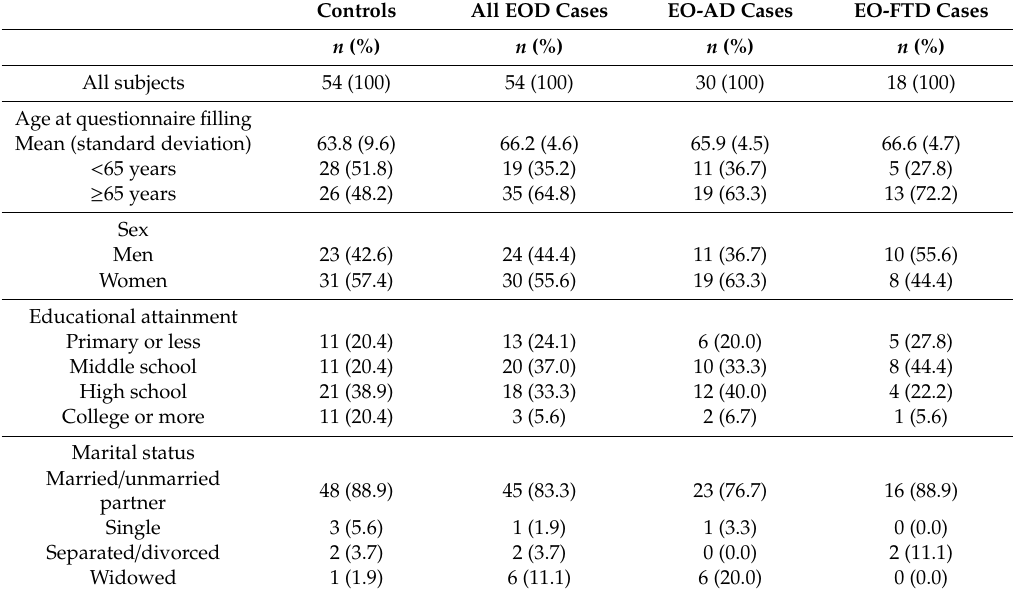
Table 1. Characteristics of the study participants. Early-onset dementia (EOD), early-onset Alzheimer’s dementia (EO-AD), and early-onset frontotemporal dementia spectrum